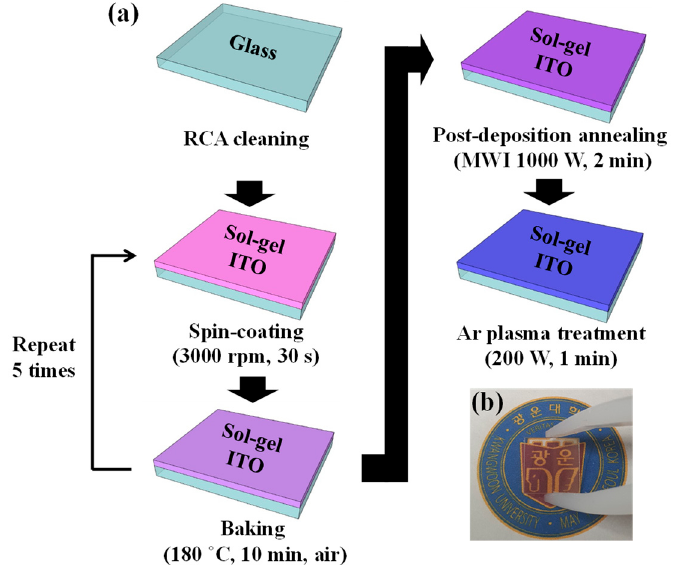
Figure 1. ( a ) Fabrication steps for sol–gel indium–tin–oxide (ITO) thin films; ( b ) photograph of the ITO-coated glass sample (MWI: microwave irradiation).